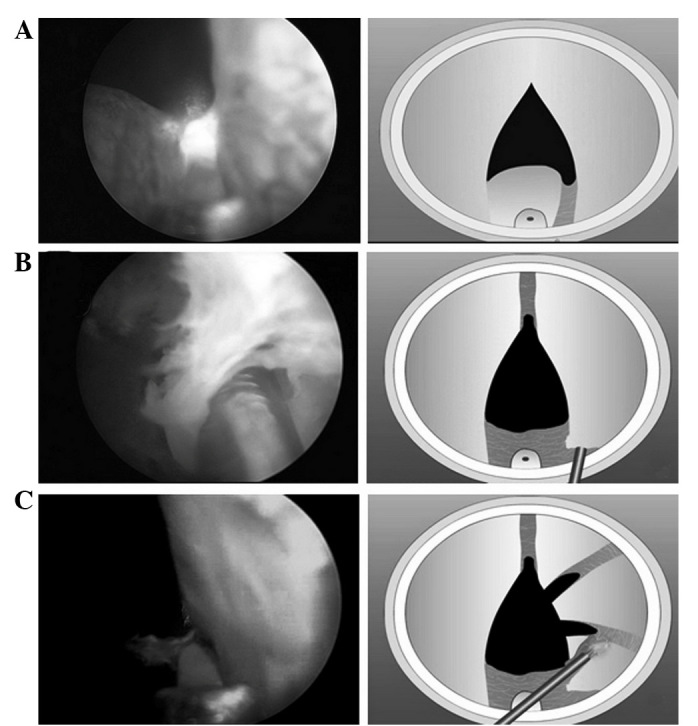
Surgical process of vaporization resection: left, operation video image; right, corresponding animation diagram. (A) Initial incision at 5 o’clock; (B) the left tip blunt dissection process; (C) resecting and segmenting left lobe.